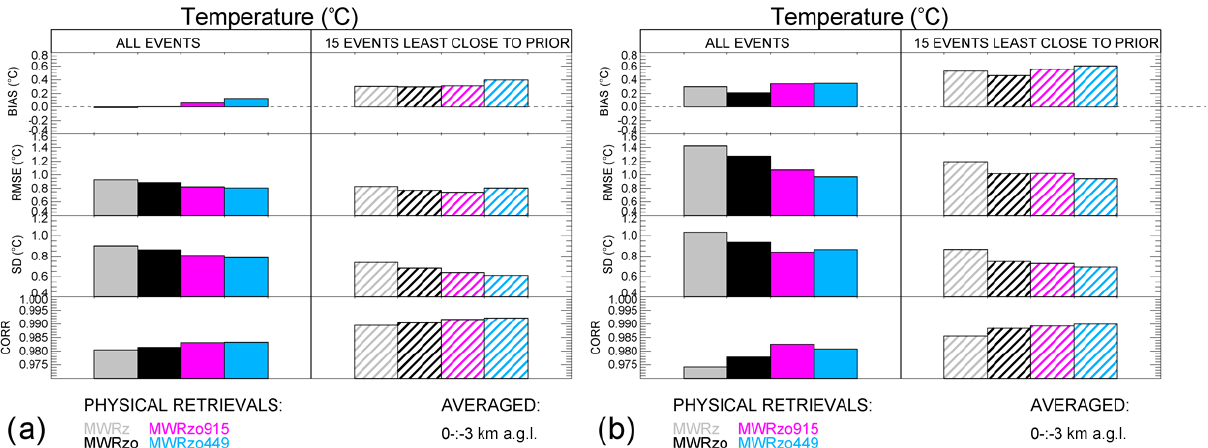
Figure 8. From top to bottom: biases (retrievals minus radiosonde), RMSEs, standard deviations of the difference between retrievals and radiosonde, and Pearson correlations for the four PR configurations, averaged from the surface to 3km a.g.l., over all radiosonde data (solid boxes), and over the 15 extreme cases (hatched boxes). The data in panel (a) use radiosonde BC and in (b) TROPoe BC on the MWR T b s. Table 2. Retrieval improvements for different RASS/MWR configurations as a percentage compared to